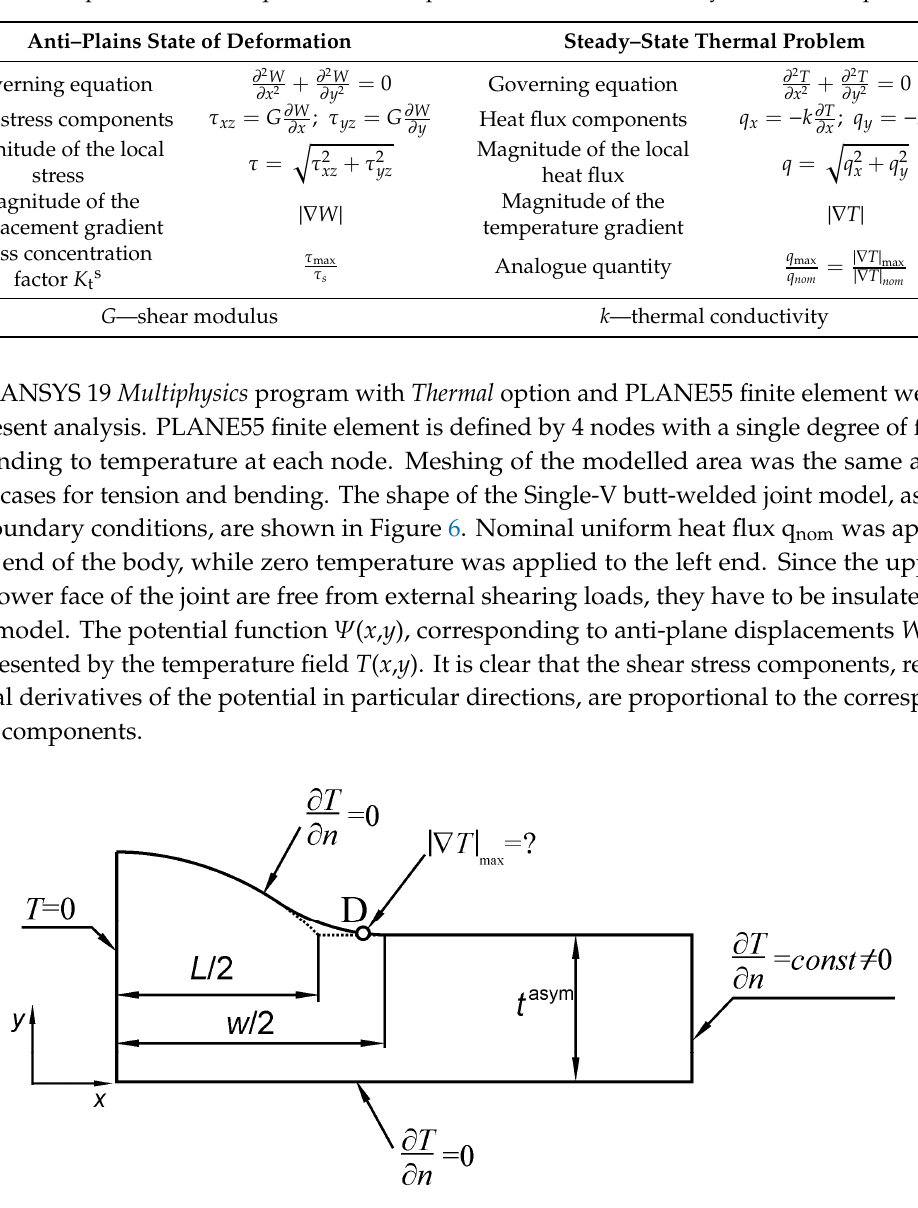
Figure 6. Boundary conditions for calculating stress concentration factors (SCFs) of a butt-welded joint subjected to anti-plane shear using thermal analogy. subjected to anti-plane shear using thermal